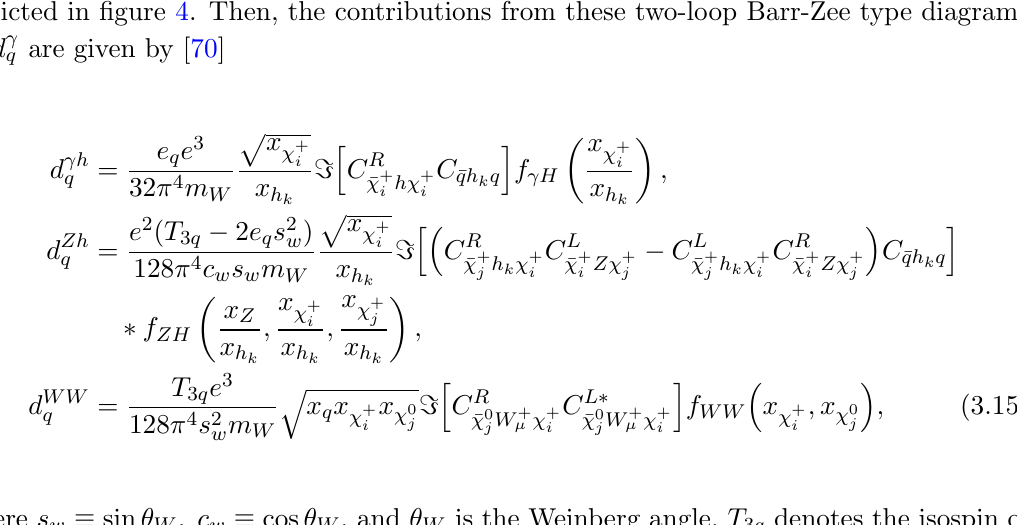
Figure 2 . The two-loop diagrams which contributes to d (cid:13) photon and a gluon respectively to the internal particles in all possible